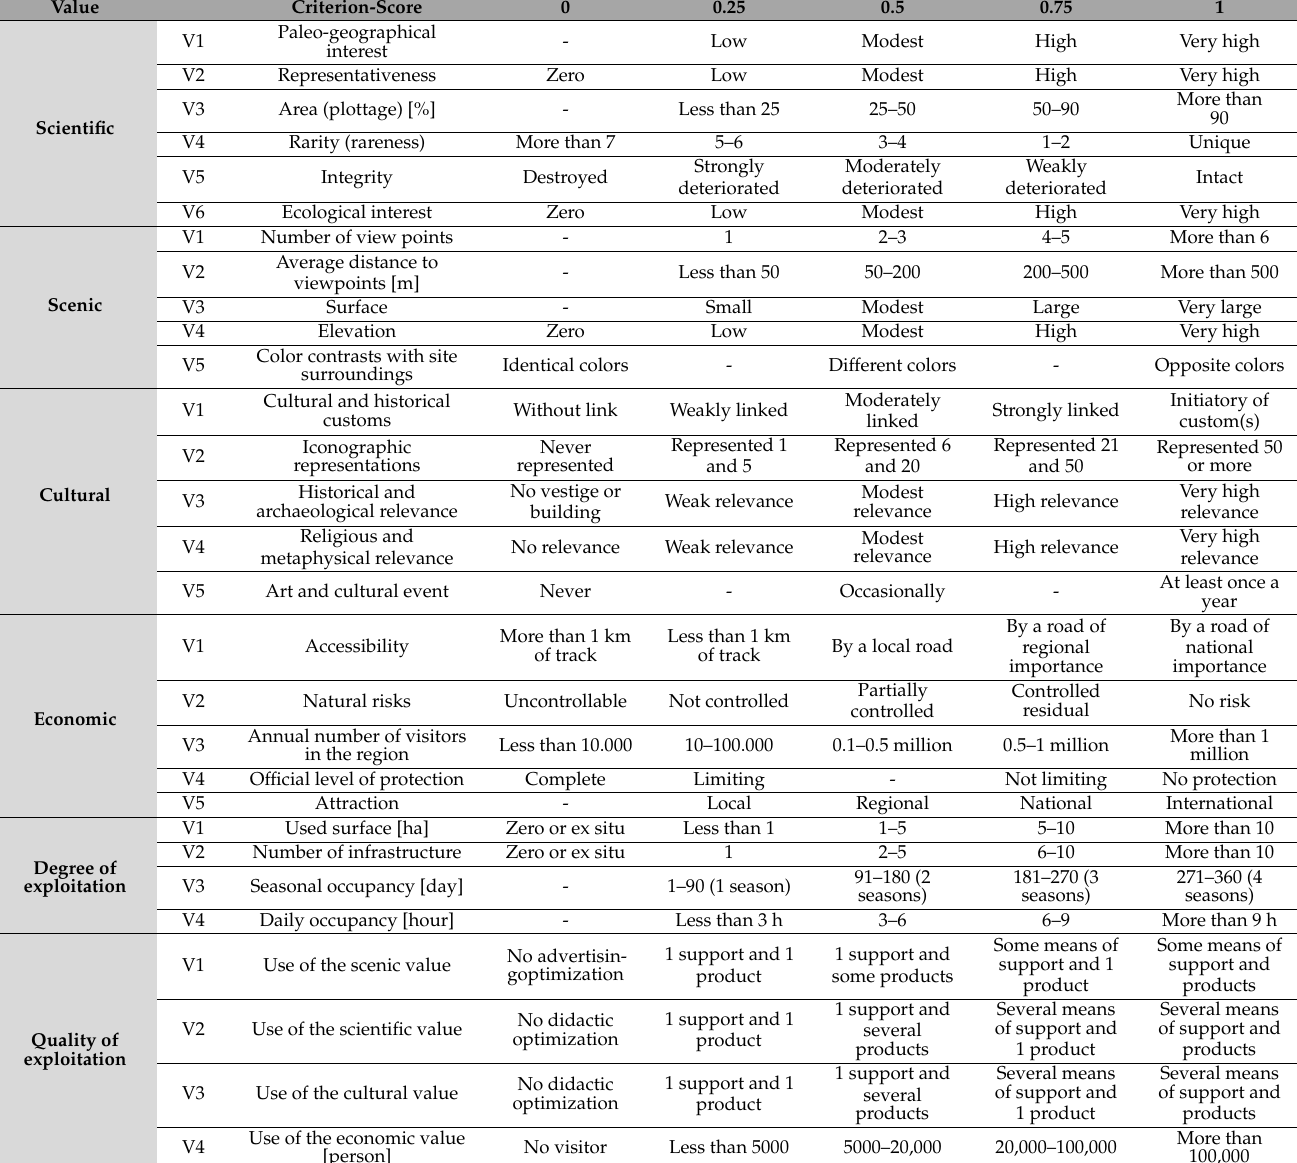
Table 1. The evaluation of the four geomorphosite/geosite criteria and the value of tourism produc- tivity, based on the Pralong